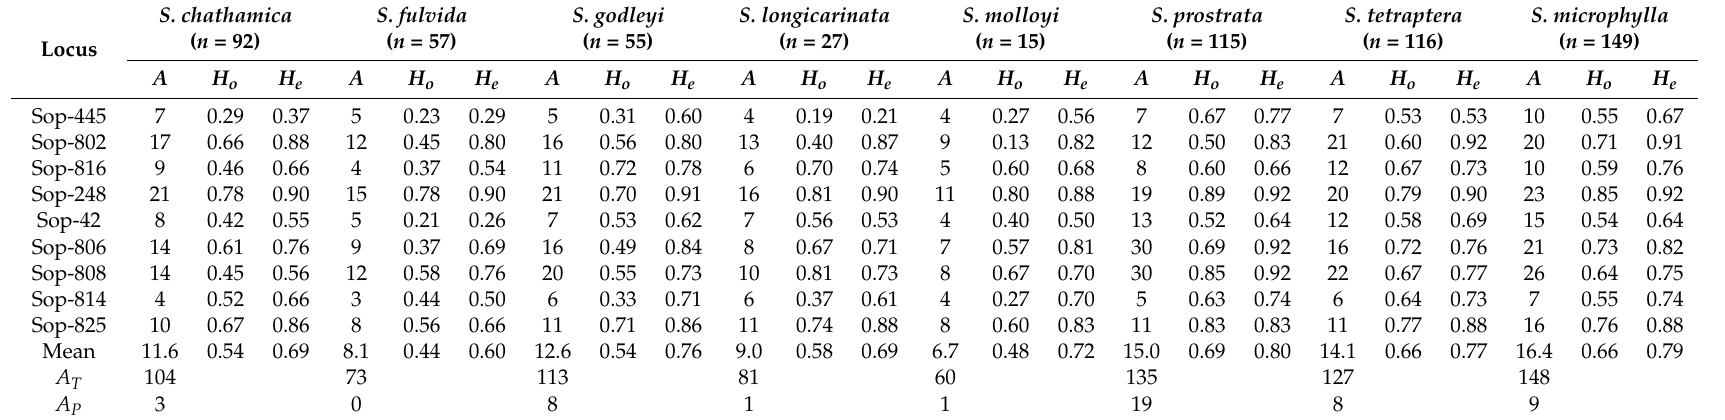
Table 1. Genetic diversity parameters for eight Sophora species from nine microsatellite